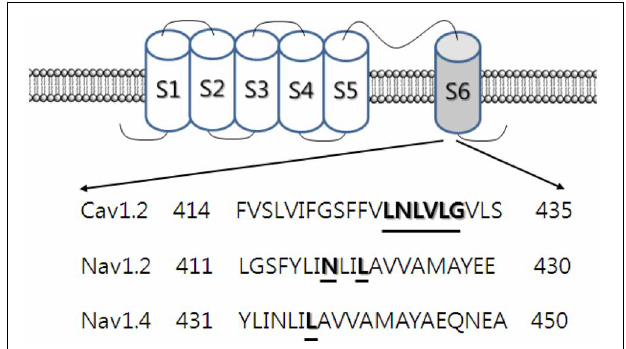
FIGURE 2 | Topology and sequence alignment of Cav1.2, Nav1.2, and Nav1.4 channels. Ca 2 + and Na + channels consist of the main α subunit and other auxiliary subunits. α subunit has 4 domains and each domains contain 6 segments. Each segment 4 plays a membrane voltage sensor and segments 5 and 6 form channel pore. The mutated amino acid residues are underlined in the pore-forming segment 6. The underlined specific amino acid residues in these channels are thought to interact with 20( S )-ginsenoside Rg 3 (Rg 3 ) (Lee et al., 2008b; Choi et al., 2009).